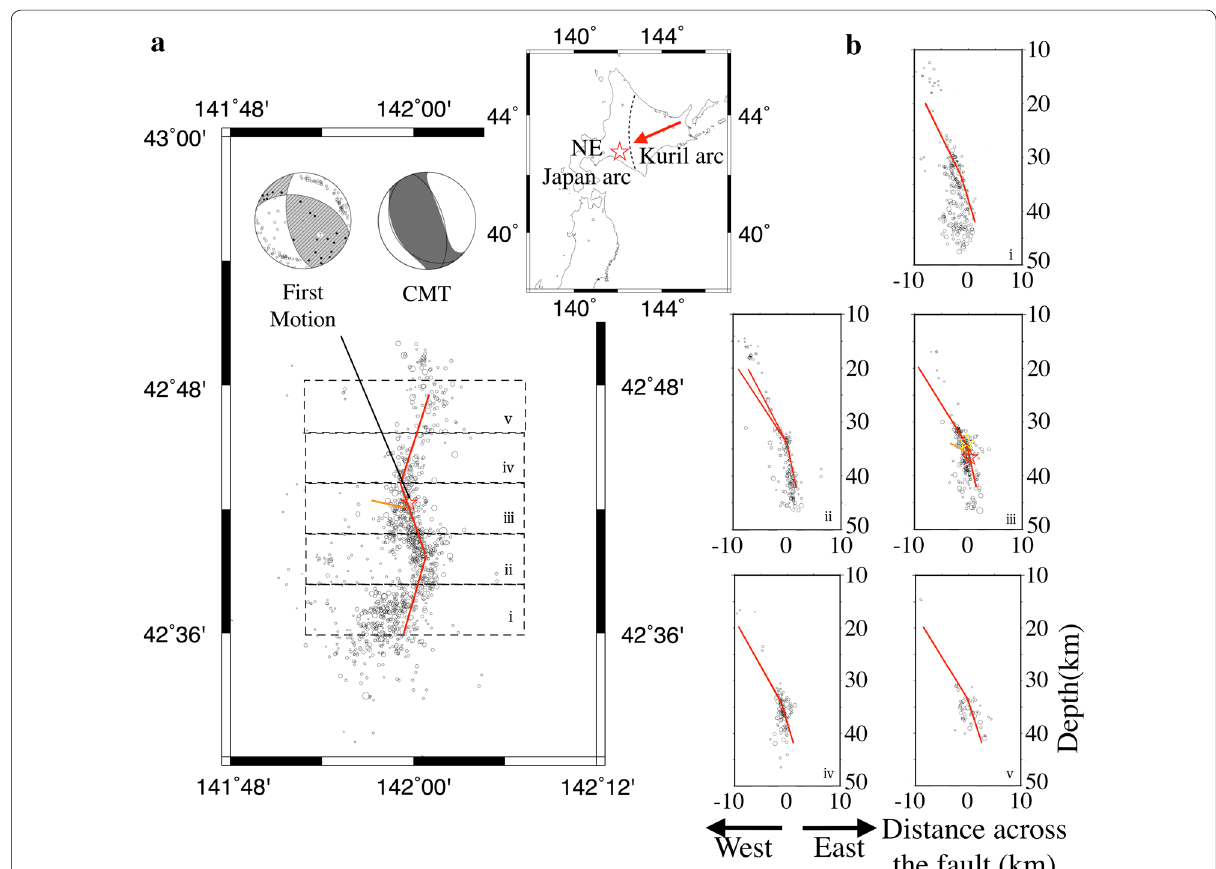
Fig. 1 Relocated aftershock distribution and the assumed fault model. Black circles represent the hypocentral locations of the aftershocks. Inset: tectonic setting of Hokkaido corner region. The red arrows and the dotted line indicate the direction of the relative movement of Kuril arc against the northern Japan island ark and the inferred border of them (Kita et al. 2012), respectively. a The map view of aftershock distribution. The red star indicates the observed mainshock epicenter. The red lines show the cross-sectional projection of the assumed fault at a depth of 34 km. The orange line shows the branch fault (Segment N) added in Case B. b The cross-sectional views for the sections i–v; the red and orange lines show the cross-sectional projection of the assumed fault surfaces on the middle of each section, respectively. The red star indicates the locations of the observed hypocenter and the assumed hypocenter in Case B, and the yellow star indicates the assumed nucleation location in Case A without the branch